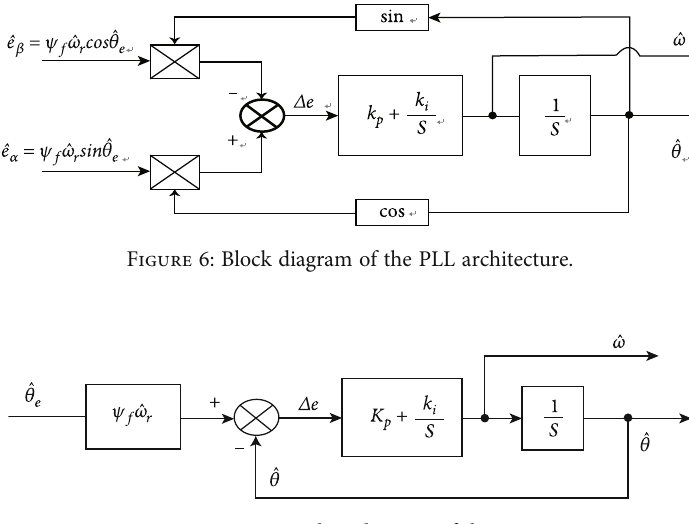
Figure 7: Equivalent diagram of the